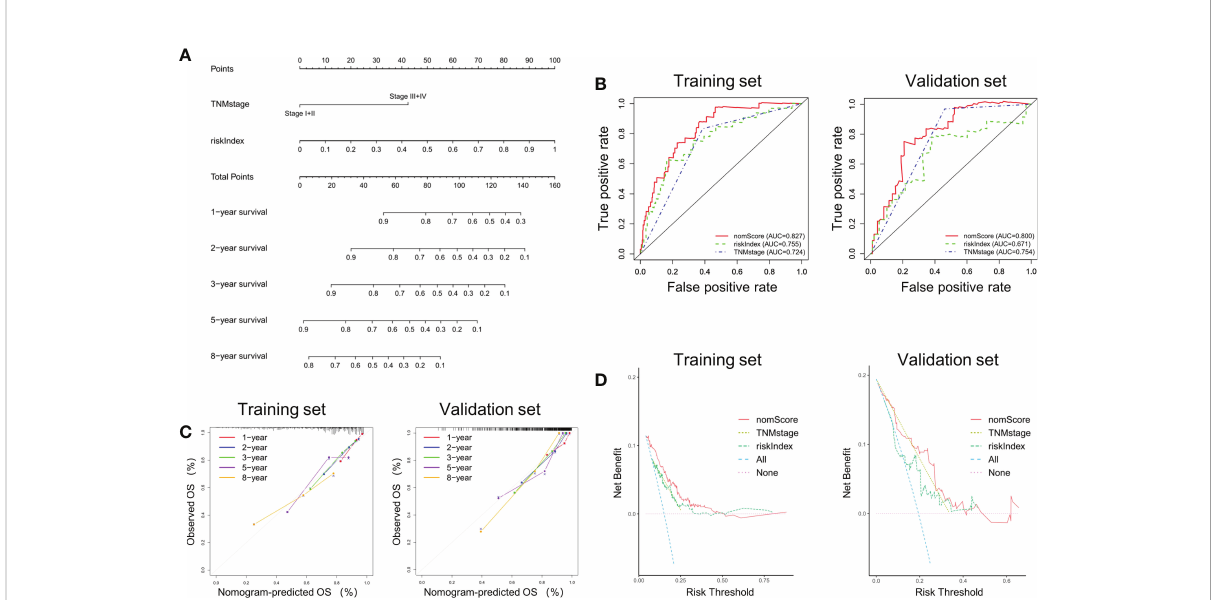
FIGURE 4 Nomogram based on riskIndex and TNM stage for external validation. (A) Nomogram comprised the riskIndex and TNM stage for predicting the prognosis probability in CRC. (B) ROC curves for comparison of the nomogram, riskIndex and TNM stage in the training and validation datasets. (C) Calibration curves of the nomogram to predict the 1, 2, 3, 5 and 10-year survival rates. (D) DCA of the integrated nomogram in the training and validation